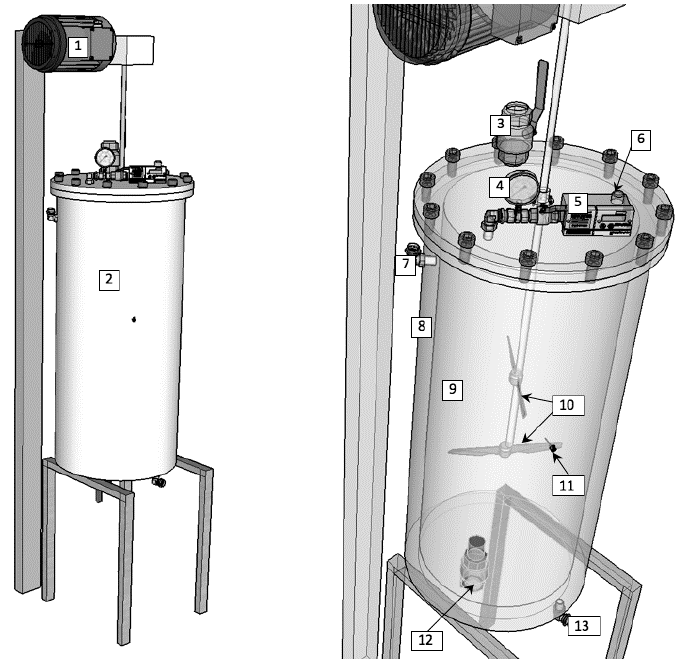
Figure 2. Experimental stand. (1) Electric engine, (2) fermenter with tooling, (3) shutoff valve/substrate feeder, (4) manometer, (5) biogas flow meter, (6) biogas outlet, (7) water jacket feed valve, (8) watercoat, (9) reactor chamber, (10) stirrers, (11) PT-100 temperature sensor, (12) shutoff valve/post-fermentation outlet, (13) water jacket drain valve.